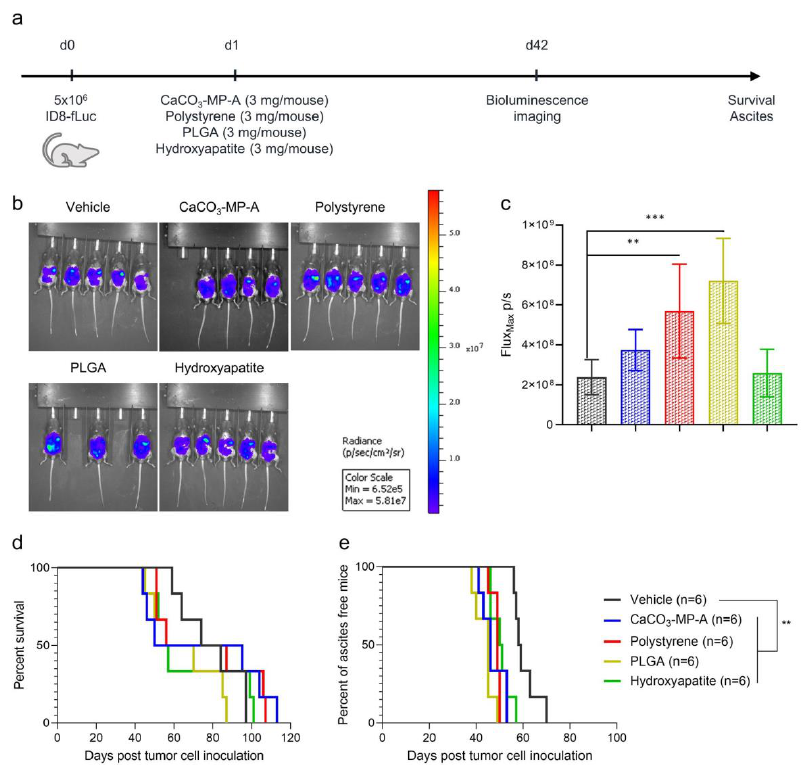
Figure 1. Experimental set-up of the experiment ( a ) with corresponding bioluminescence imaging visualization ( b ) and quantification ( c ) and Kaplan–Meier curves for survival and time to ascites development ( d , e ) of mice injected with vehicle control, 3 mg of CaCO 3 -MP-A, 3 mg of polystyrene, 3 mg of PLGA or 3 mg of hydroxyapatite. Mice showing signs of ascites development at the time point of bioluminescence imaging, were excluded from the analysis. ( b , c ): An increased tumor load was observed in mice injected with polystyrene and PLGA ( p adj = 0.0086 and p adj = 0.0006, respectively). ( d ): No effects on survival were observed between the different groups. ( e ): Mice injected with CaCO 3 -MP-A, polystyrene, PLGA and hydroxyapatite showed a significant acceleration of malignant ascites development compared with vehicle control ( p adj = 0.0011, p adj = 0.0011, p adj = 0.001 and p adj = 0.0033, respectively). PLGA: polymer poly (lactic-co-glycolic acid). Degree of significance: p adj < 0.01 (**), p adj < 0.001